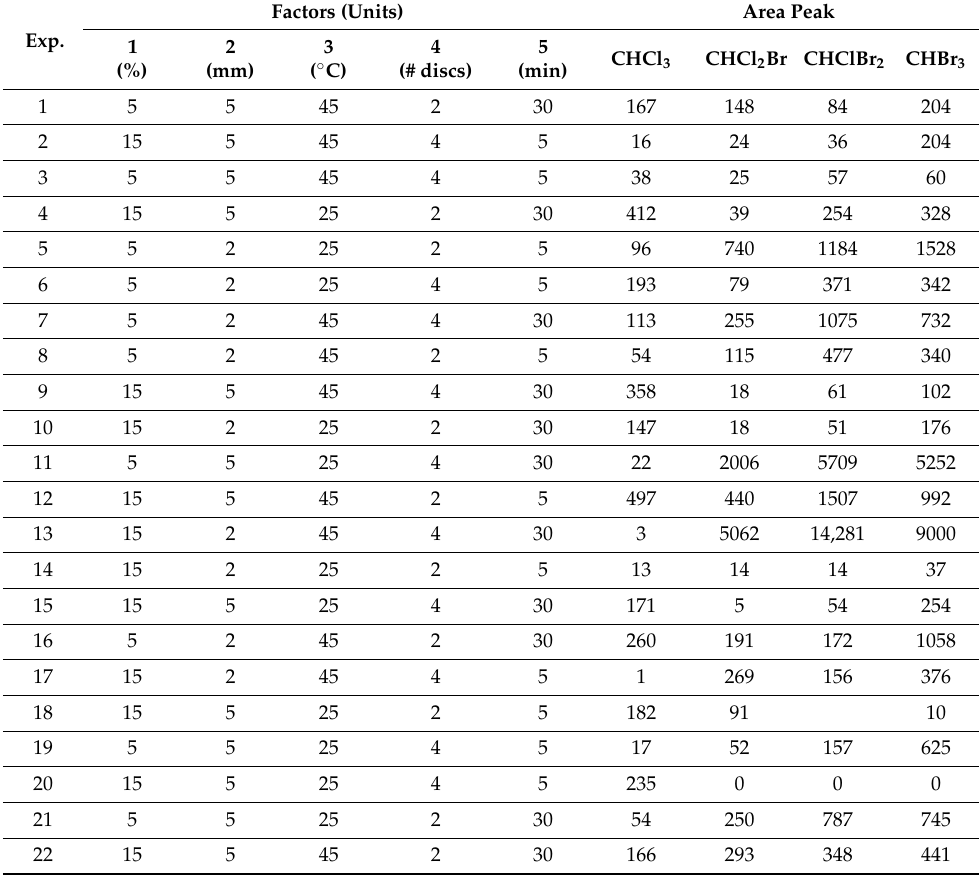
Table 2. Results of the optimization extraction by HS-SPME by using a new hybrid ecomaterial of MMT-IL-AF as sorbent phase from spiked sample at 500 ng mL − 1. Exp.